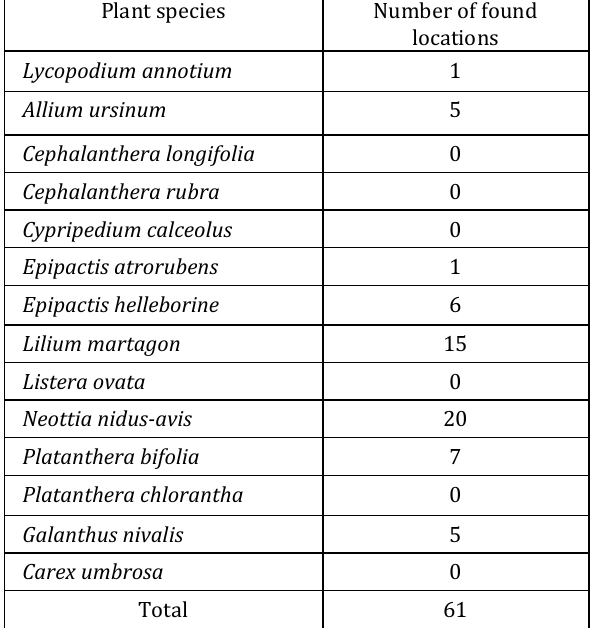
Table 1. Number of locations of rare species found in the Volyn Upland by the author Plant